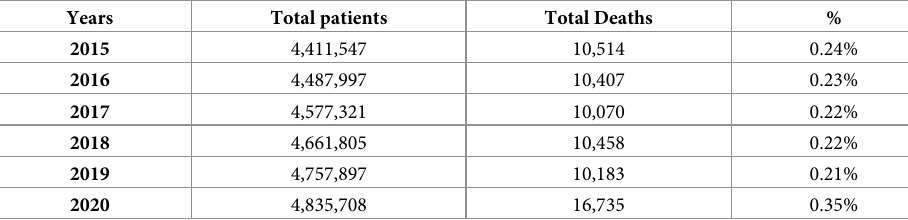
Table 1. Summary of annual patient cohorts based on 18th March to 19th May dates.